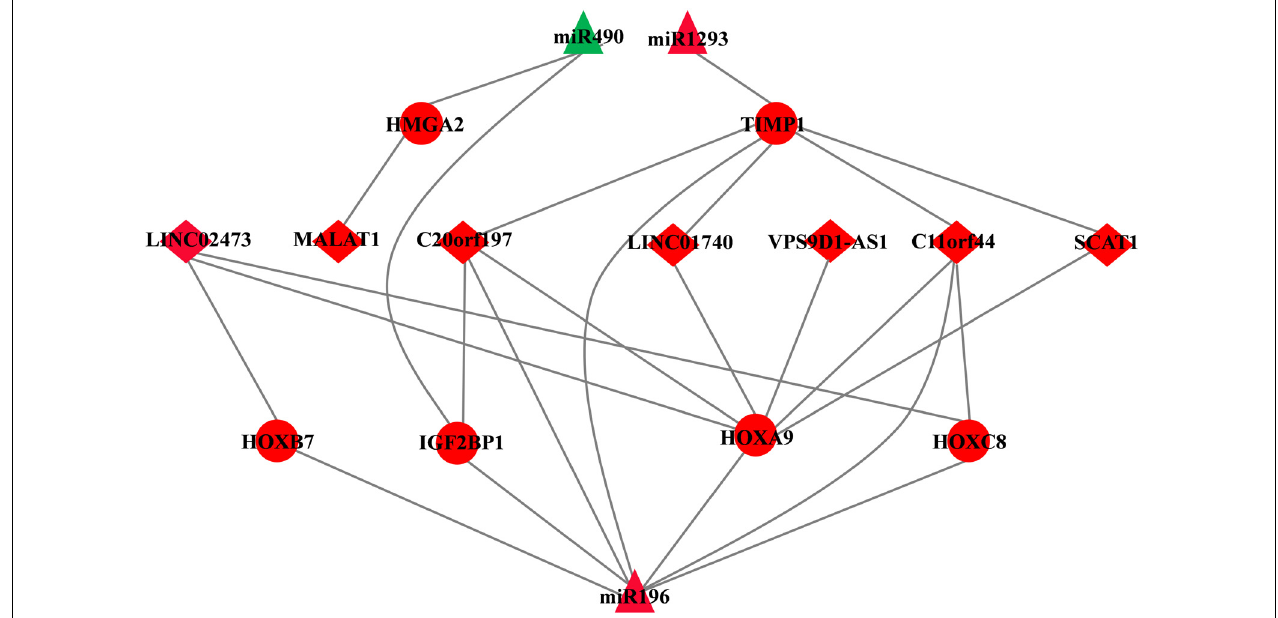
FIGURE 4 | CeRNA network of LUAD. The triangles indicate miRNAs, circles mean mRNAs, and diamonds represent lncRNAs. Red means up-regulated, and green means down-regulated.